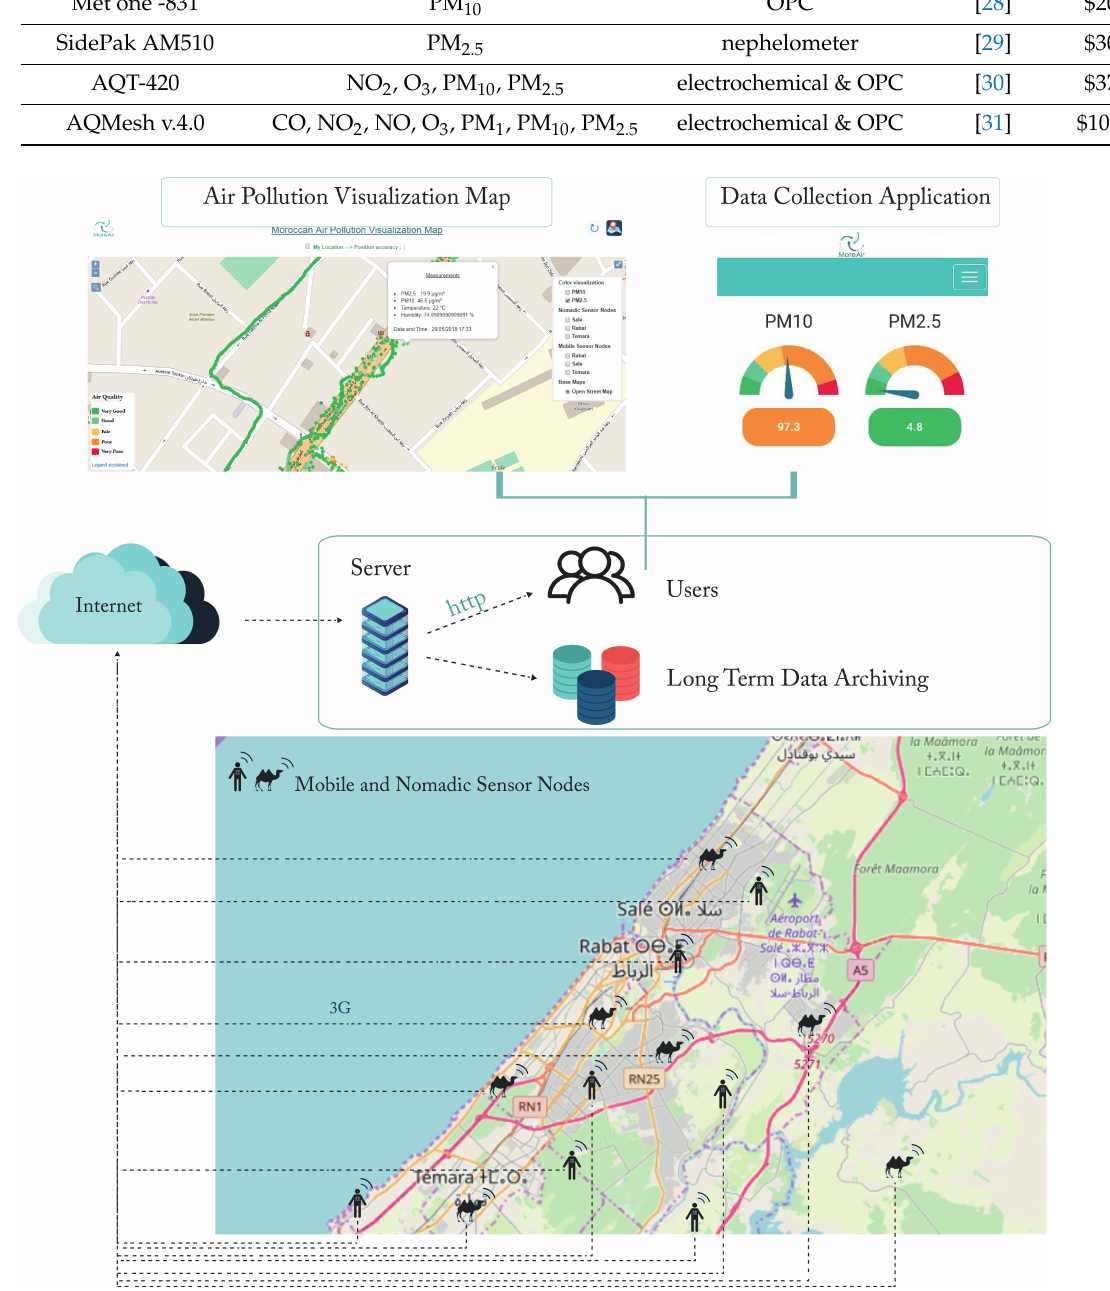
Figure 1. General architecture of the IoT